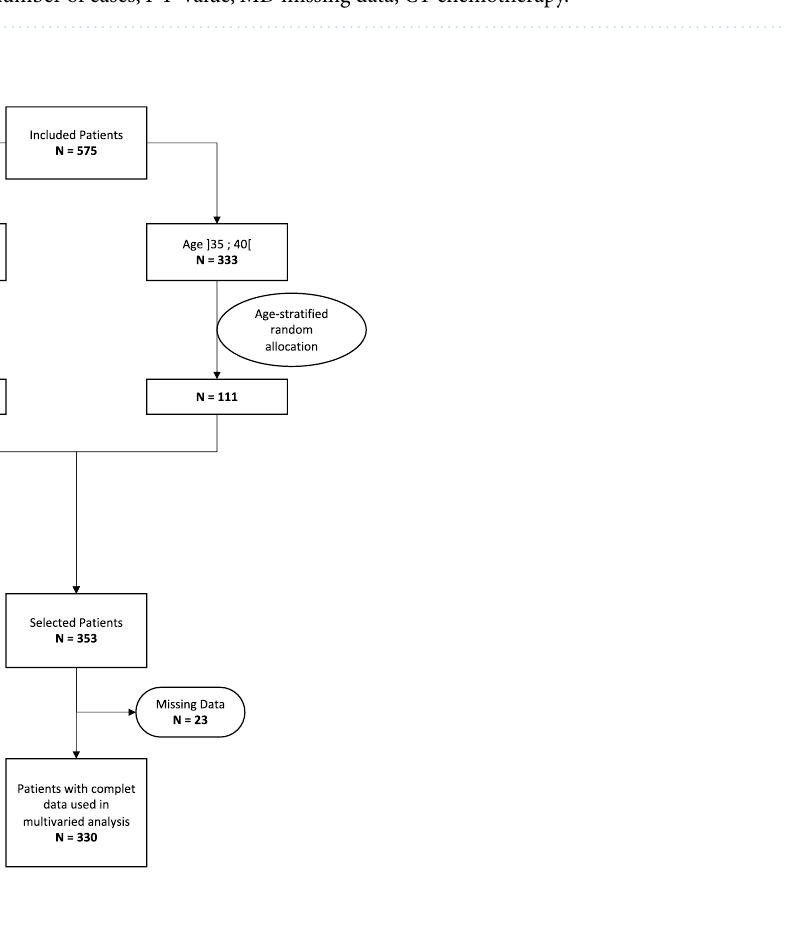
Table 1. Association of variables with information provision and oncofertility consultation (bivariate analysis). N* weighted number of cases, P P-value, MD missing data, CT chemotherapy.